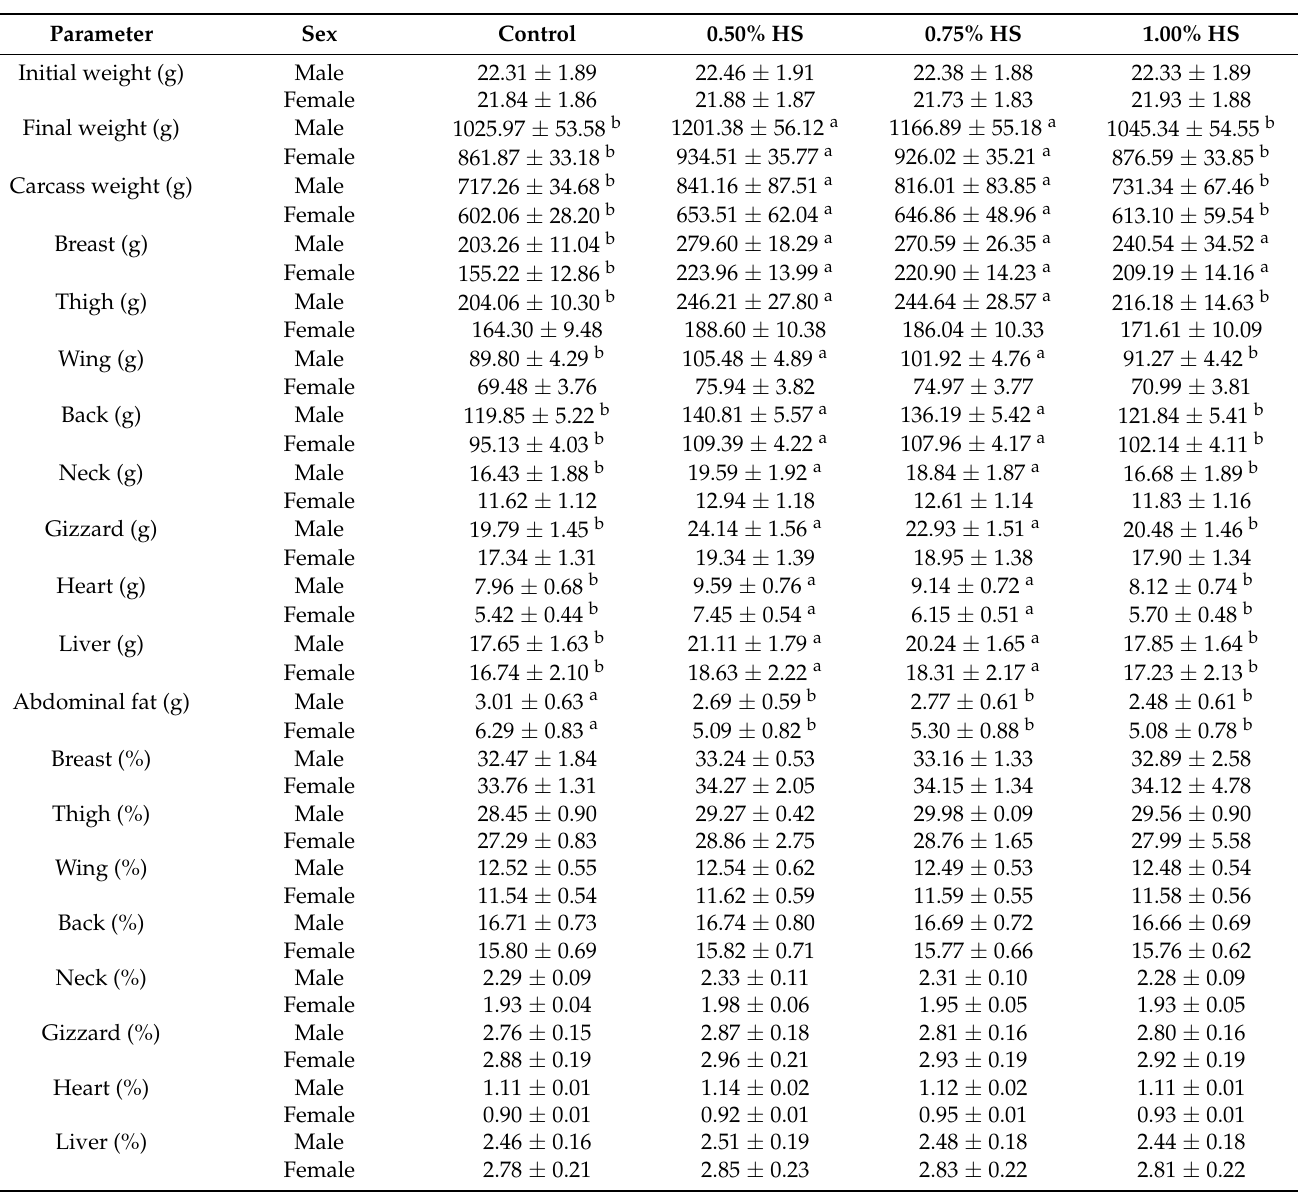
Table 3. The effect of HSs on the carcass characteristics of